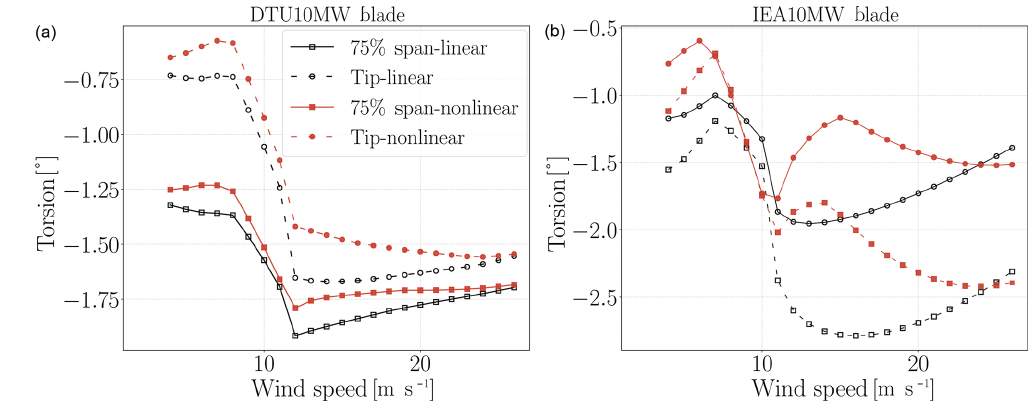
Figure 4. Linear and nonlinear blade model torsion deformations at 75% blade span and blade tip with respect to wind speeds for steady- wind-load cases. Panel (a) shows the DTU10MW results and IEA results are given in (b)